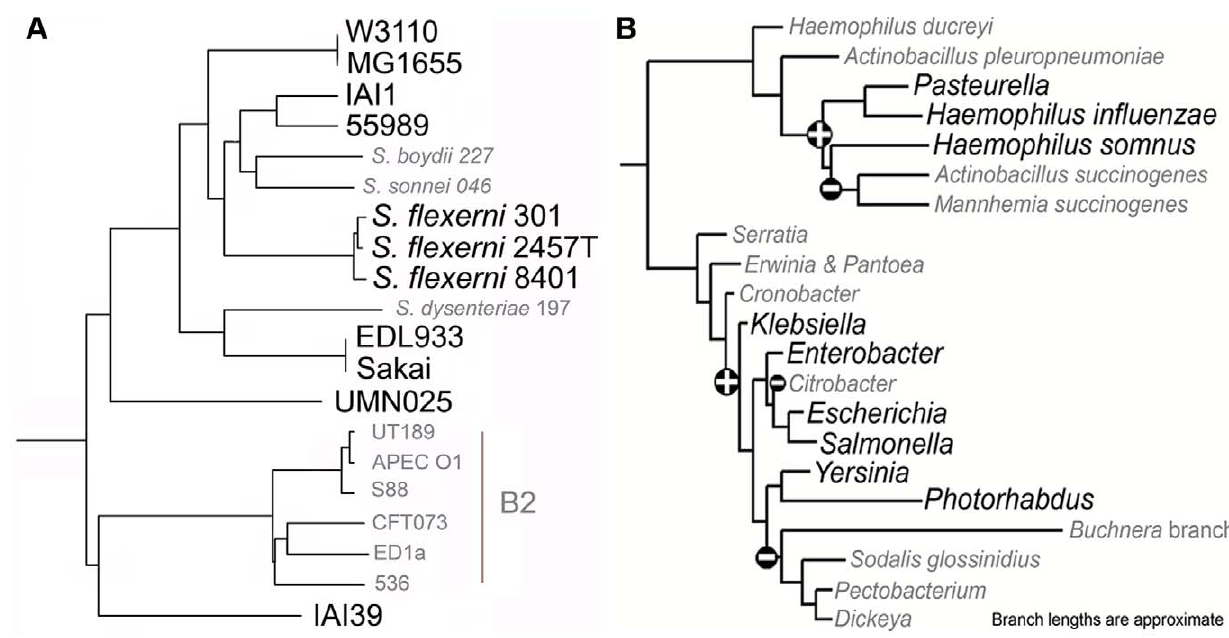
Figure 6. Lsr system LMNAST hits overlaid onto phylogenetic distributions of different scopes. A . E. coli Lsr system LMNAST hits overlaid onto an E. coli specific phylogenetic distribution as developed in and adapted from [4,27]. The larger, bolded leaves contain Lsr system homologs, whereas the grayed italicized leaves do not. Lsr system loss is evident in B2 strains. B . E. coli Lsr system LMNAST hits overlaid onto an Enterobacteriales and Pasteurellales phylogenetic distribution adapted from [34]. The larger, bolded leaves contain Lsr system homologs, whereas the grayed italicized leaves do not. Loss and gain events are denoted by – and + respectively based on parsimony. Compared to the distribution of the lac operon, Lsr is more dispersed but also shallower,